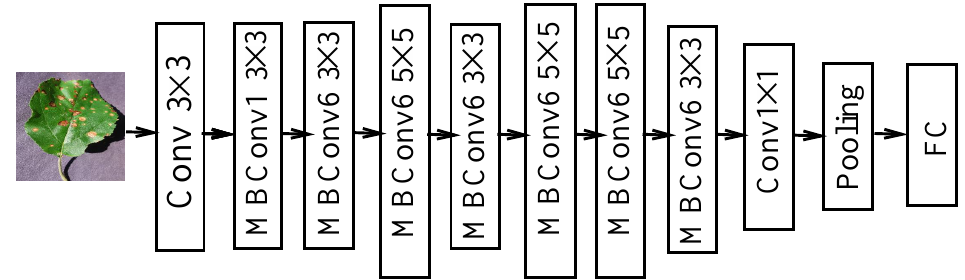
Figure 5. Basic block diagram of EfficientNet